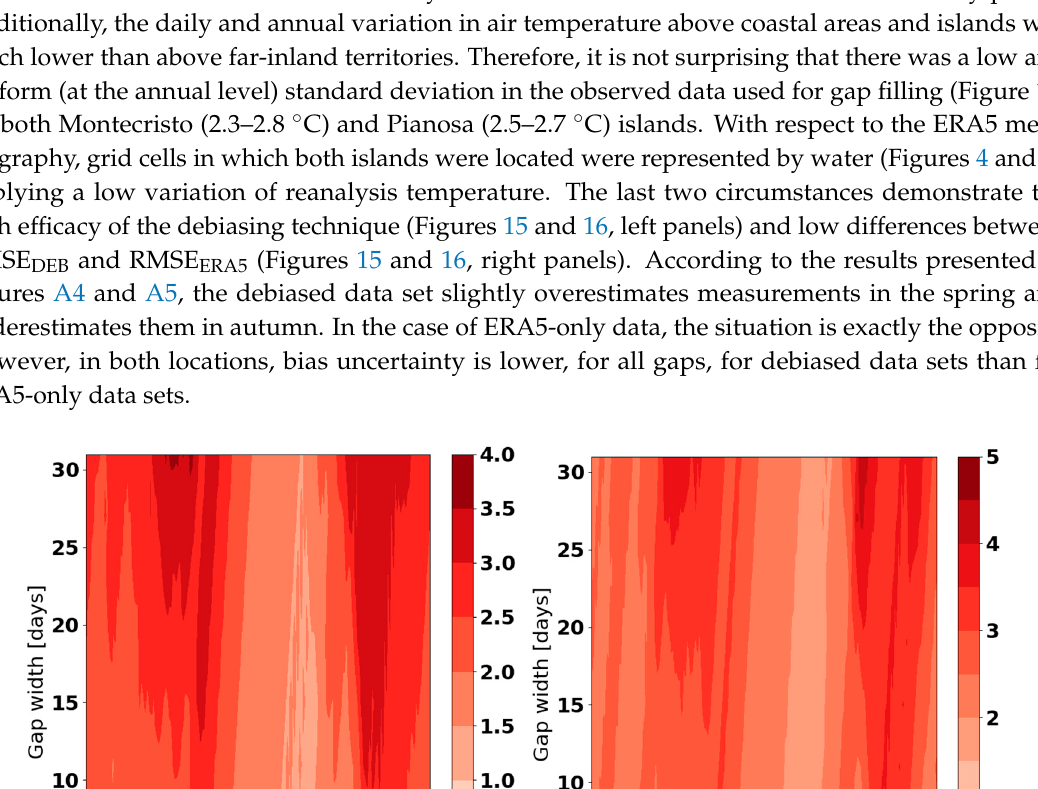
Figure 13. Daily variation in air temperature for DOY 215–226 inBahariya (Egypt).